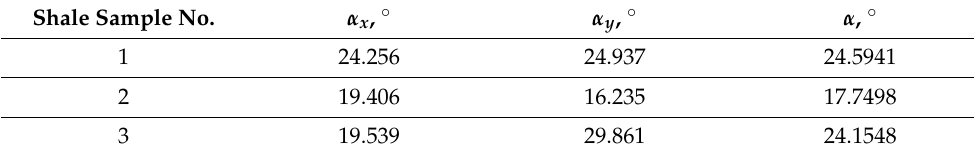
Table 5. Absolute dip angle of shale fracture surface